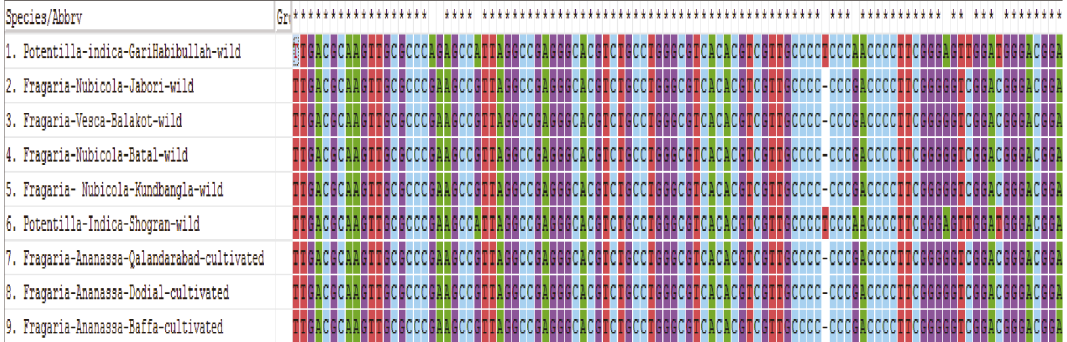
Figure 2: Alignment of Fragaria species of the ITS2 marker.